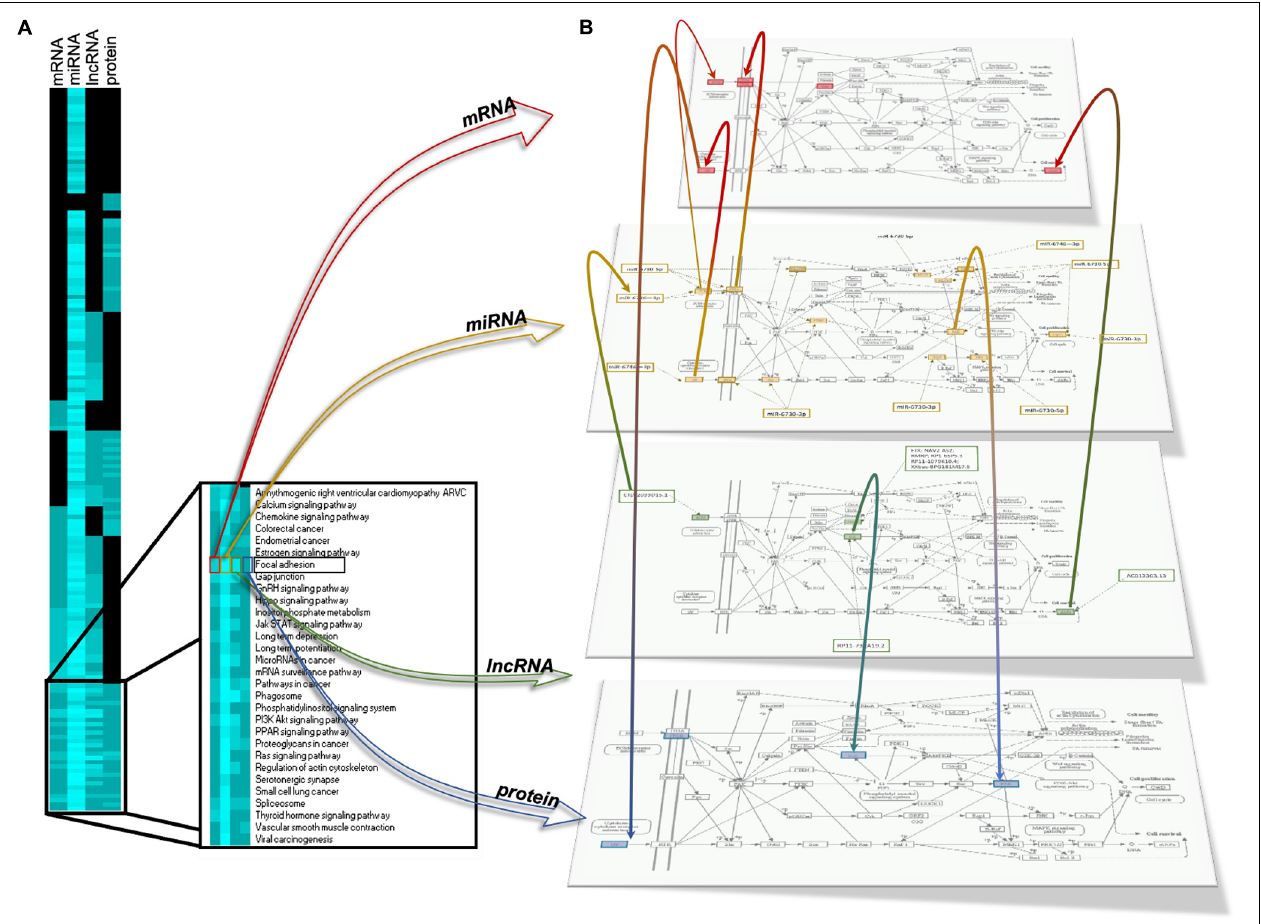
FIGURE 10 | Integration of differentially expressed mRNAs, microRNA target gene, lncRNA target gene and protein modulating focal adhesion function in human brain microvascular endothelial cells treated with γ -valerolactones and stressed with TNF- α . (A) Heatmap of differentially expressed gene pathways, miRNA target gene pathways, lncRNA gene pathways and protein pathways. The intensity of the blue color depends on the number of genes in each pathway, the lighter blue color is indicative of a higher number of genes. Comparisons of pathways between biological categories identified a group of pathways in common including chemokine signaling pathway, cytokine cytokine receptor, focal adhesion, gap junction, FOXO signaling, fatty acid metabolism, and pathways that regulate endothelial cell interaction and permeability. (B) A representative integrated analysis of differentially expressed genes and proteins, and target genes of differentially expressed miRNAs, lncRNA is shown for Focal adhesion. Yellow = differentially expressed genes; Red = target genes of differentially expressed miRNAs, Green = target genes of differentially expressed lncRNAs, Blue = differentially expressed proteins. Color gradations = genes identified in both omic